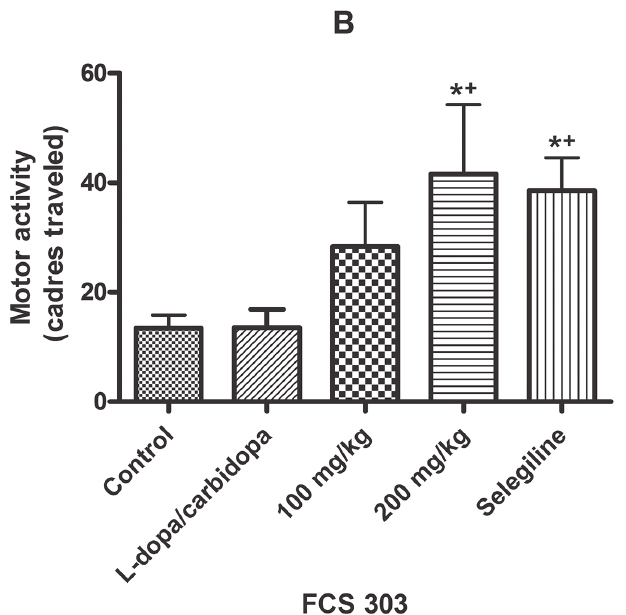
FIGURE 4B - Effect of administration of levodopa/carbidopa (100/10 mg/kg) plus FCS303 (100 and 200 mg/kg), control (vehicle 0.1 mL/10 g body weight), or selegiline (10 mg/kg) on motor activity in mice pre-treated with reserpine (3